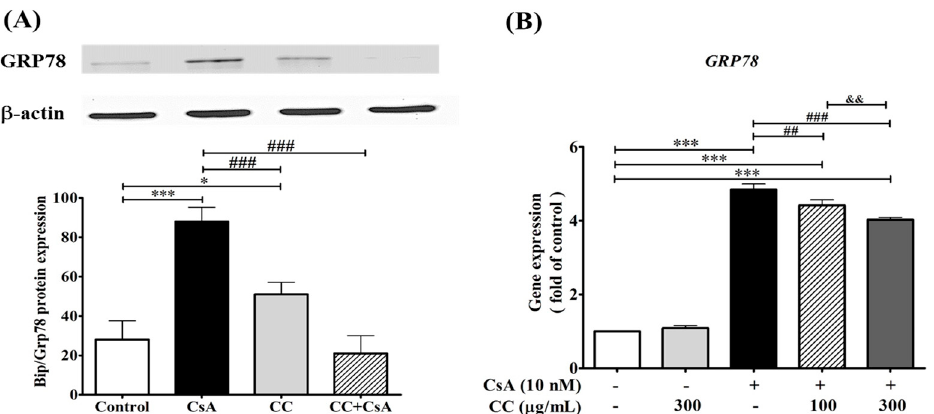
Figure 6. Cordyceps cicadae mycelia extract (CCM) protects cell from cyclosprorine A (CsA)-induced expression of glucose regulated protein 78 (GRP 78) in rat renal cells ( A ) and human renal cell line HK-2 cells ( B ). ( A ): The protein expression of GRP 78 increased during CsA challenge, compared to the control, and was counteracted by CCM cotreatment (CC + CsA) in rat. Each column represents the mean ± SEM (n = 6). Different letters indicate a significant difference ( p < 0.05). ( B ): Human renal cell line HK-2 cells were treated with CsA (10 nM) for 2 h and then incubated with 100 and 300 μ g/mL of CCM for 24 h. The m-RNA expression of GRP 78 of human renal cell line HK-2 cells was inhibited by CCM treatment in a dose-responsive manner. Data are presented as mean values ± S.D of three experiments. * p < 0.05 and *** p < 0.001 vs. control. ### p < 0.001 and ## p < 0.01 vs. CsA group. && p < 0.01.